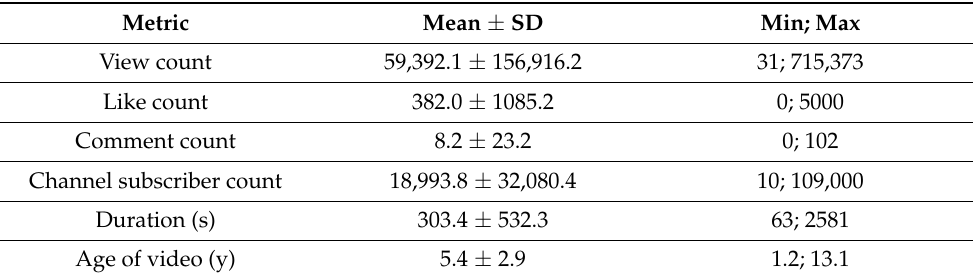
Table 4. Viewing metrics of the 21 videos.